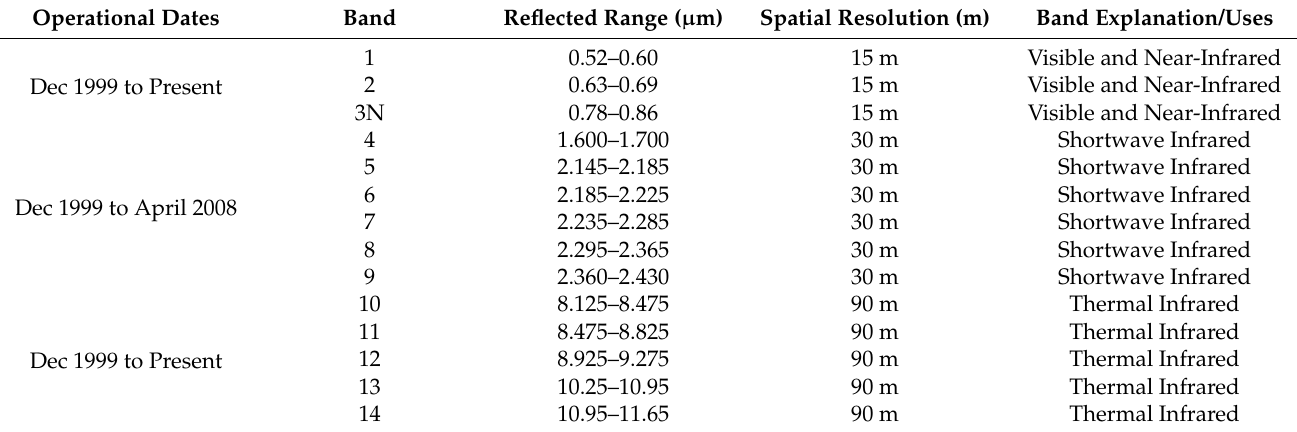
Table 1. The ASTER bands features [29].